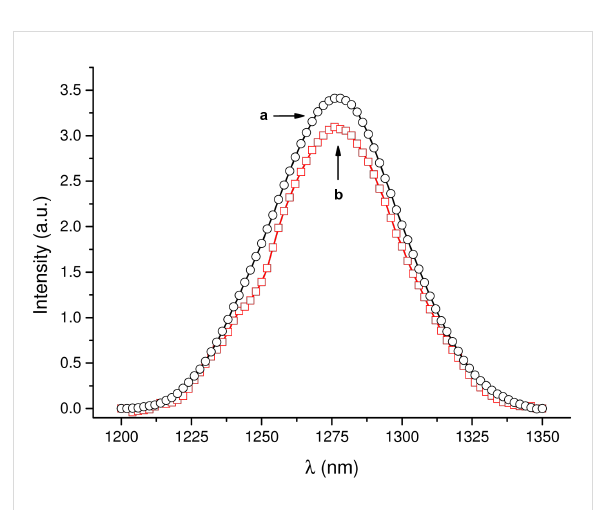
Figure 8: 1 O 2 luminescence detected upon 528 nm light excitation of D 2 O solutions of (a) eosin Y ( 2 ) and (b) 2 – β -CD conjugate having the same absorbance at the excitation